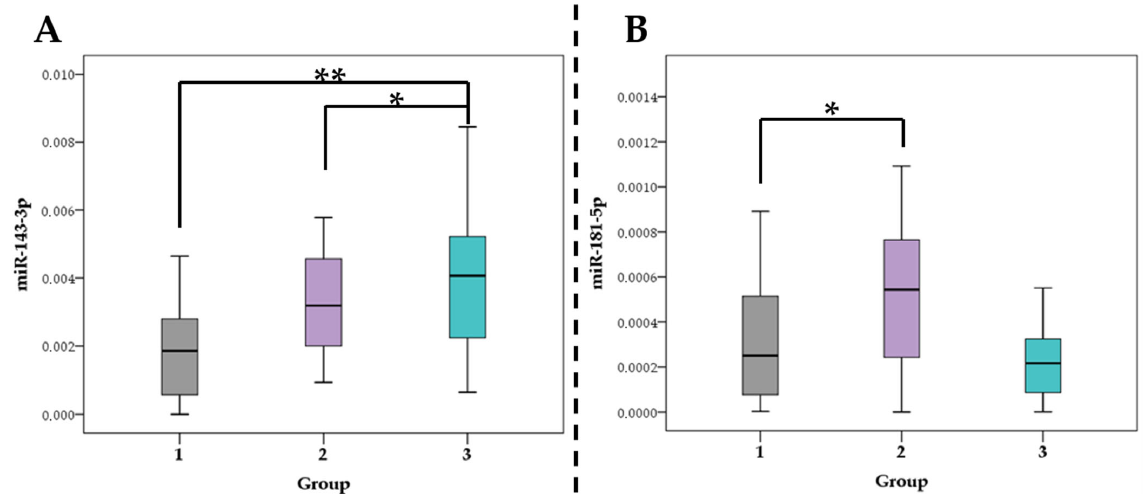
Figure 2. Results of comparison of miRNA relative plasma level in patients with different characteristics of atherosclerotic plaques (nonparametric test for comparison of multiple Kruskal–Wallis groups due to data distribution different from normal). ( A ) miR-143-3p relative levels. * p -value = 0.0457, ** p -value = 0.0046; ( B ) miR-181b-5p relative levels. * p -value = 0.0179.